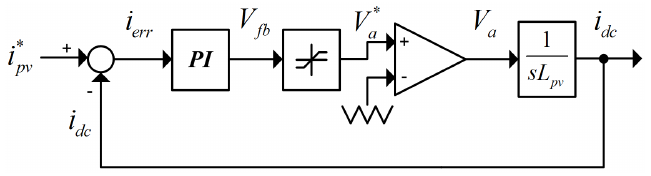
Figure 3. Conventional PI current controller.